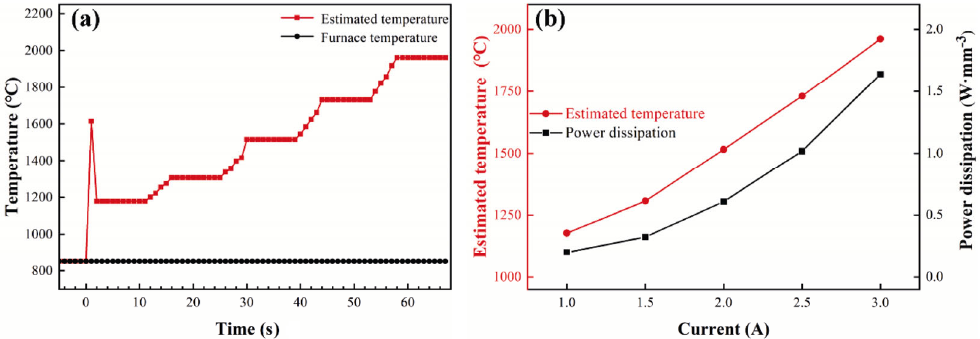
Fig. 2 (a) Estimated sample temperature versus time during flash sintering at x = 1 wt%. (b) Estimating sample temperature and power dissipation as a function of current with a preset maximum current of 3.0